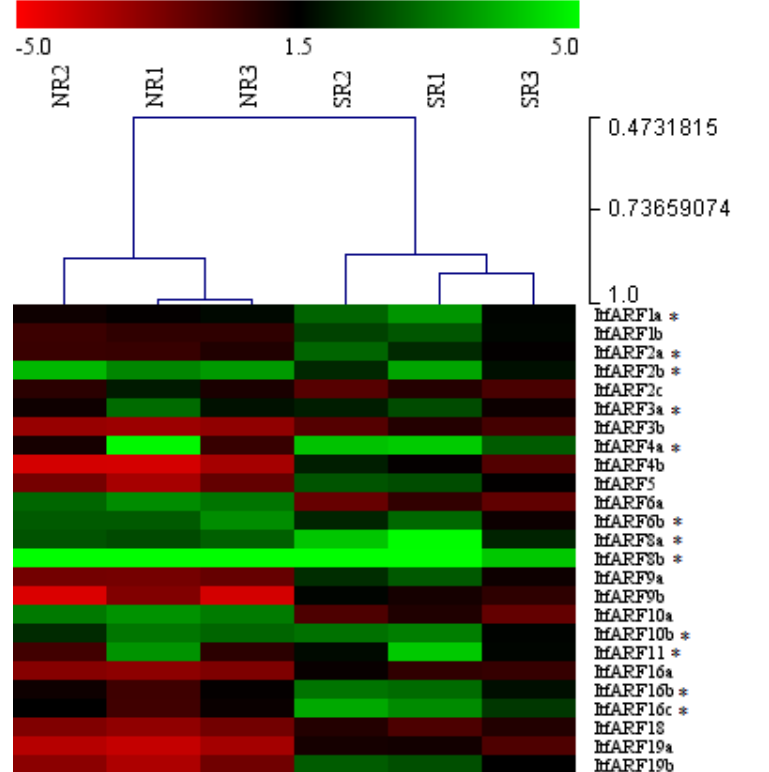
Figure 4. Heat map of ARF gene expression within all six biological samples of both the normal root and the storage root. The tissue samples are named from left to right at the top of the figure, and the names of the 25 genes are directly to the right of the figure. The expression rankings are shown using a range of color: higher gene expression is represented by green; lower expression, red; and median expression, black. *’s denotes which genes are statistically different, * p < 0.05.